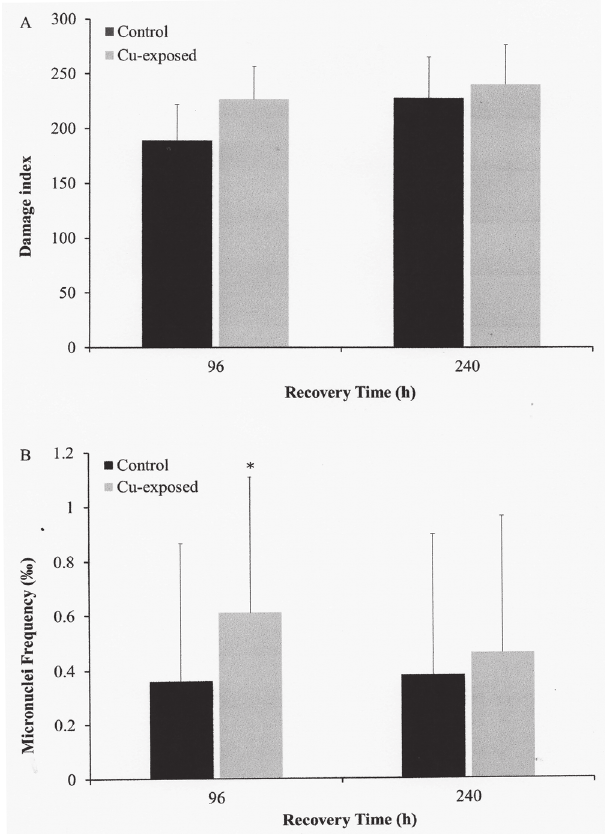
Fig. 2. DNA damage (A) and frequency of micronuclei (B) in erythrocytes in the Centropomus paralellus exposed (96 h) to Cu (0.94 mg/L), transferred to control sea water and maintained under this condition for 96 and 240 h. *Denotes significant different mean values between control and Cu- exposed fish (p<0.05). No significant difference was observed between exposure times